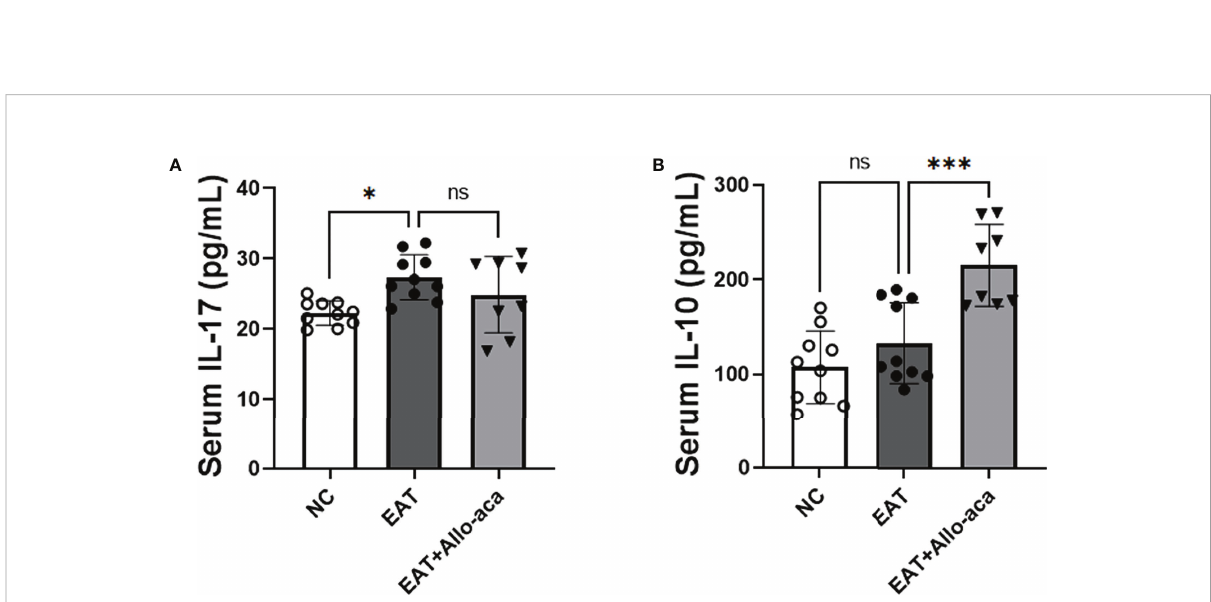
FIGURE 7 The levels of IL-17 and IL-10 in EAT mouse serum and the effect of Allo-aca on them. (A) Serum IL-17 levels in EAT mice were higher than in control mice, but Allo-aca had no signi fi cant effect on it. (B) Allo-aca signi fi cantly up-regulated serum IL-10 levels in EAT mice. n =10 in NC and EAT group, n =8 in Allo-aca group. Data is expressed as mean ± SEM. ns : not signi fi cant, * P < 0.05, *** P <